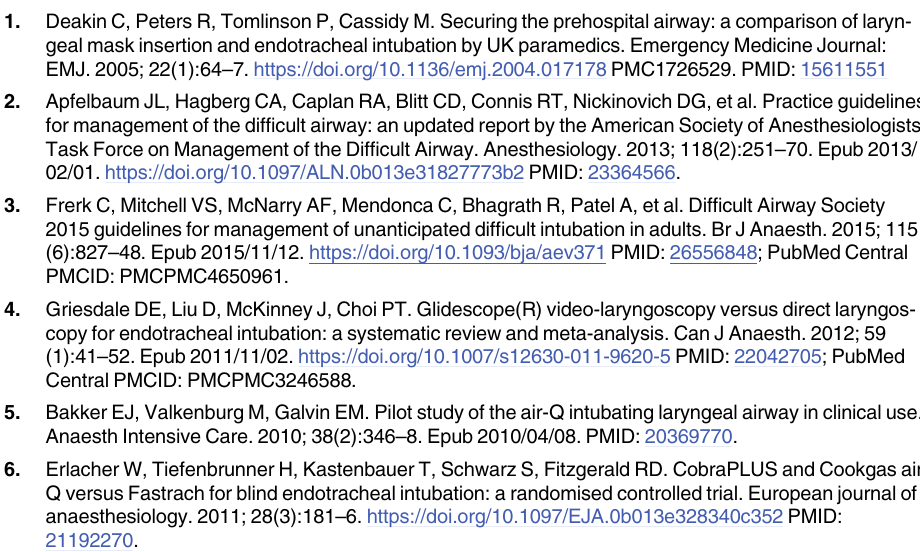
S3 Fig. The confidence intervals and predictive intervals of log estimates of the success rate of unassisted intubation. S4 Fig. Comparison-adjusted funnel